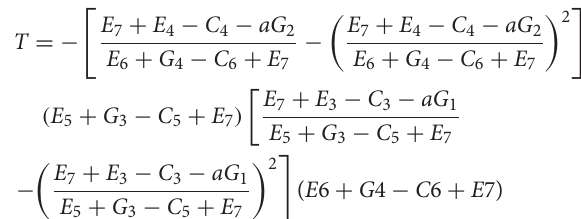
hospitals to adopt the means of vicious competition increases, moves vertically downward, or when the cost C 4 of community health service institutions to adopt the standards of fierce competition increases, D 5 moves horizontally to the left shows that the rise in input cost is conducive to the benign evolution of the system when urban hospitals or community health service institutions adopt vicious competition; When the input cost C 5 of urban hospitals increases after the cooperation of urban and rural medical and health institutions, D 5 moves vertically, or when the input cost C 6 of community health service institutions increases after the collaboration of urban and rural medical and health institutions, moves horizontally to the right, which makes the area above the broken line smaller, indicating that increasing the input cost of cooperation of urban and rural medical institutions is not conducive to the benign evolution of the system. (2) Parameters G 1 , G 2 . When the punishment G 1 of urban hospitals taking means of vicious competition under government supervision increases, D 5 moves vertically downward. When the sentence G 2 of community health service institutions taking means of ferocious competition under government supervision increases, D 5